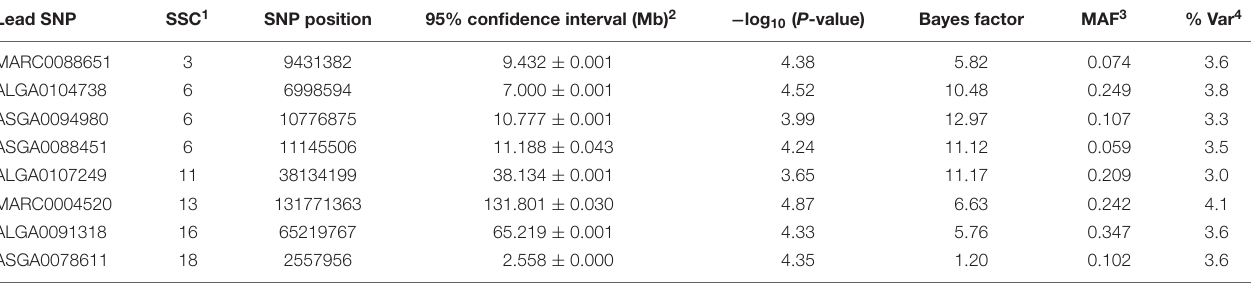
TABLE 4 | Genomic regions and corresponding lead SNPs identified by single- and multi-locus GWAS for serum levels of Ca. Lead SNP SSC 1 95% confidence interval (Mb) 2